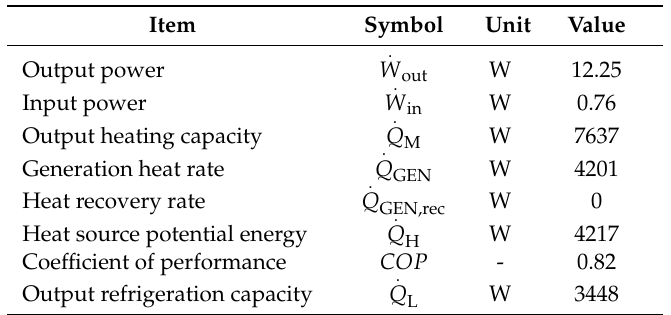
Table 2. Calculated values about the energy exchange rate in case X.